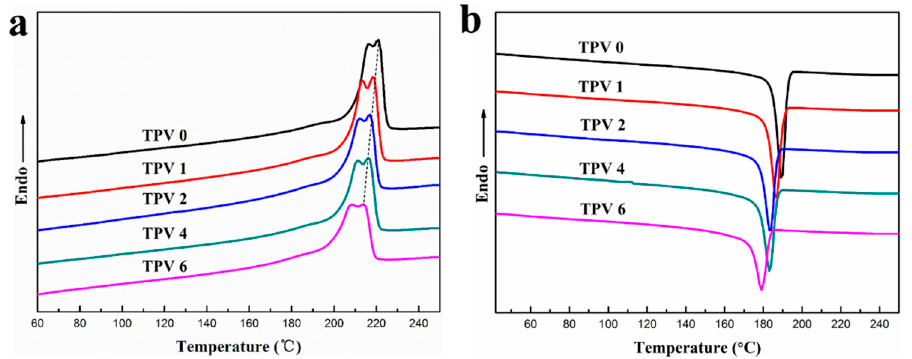
Figure 8. Di ff erential scanning calorimeter scans of TPVs during heating ( a ) and cooling ( b ) for TPVs with di ff erent PF loading. Table 2. Di ff erential scanning calorimetry (DSC) parameters of non-isothermal crystallization and the following melting process for TPV series.